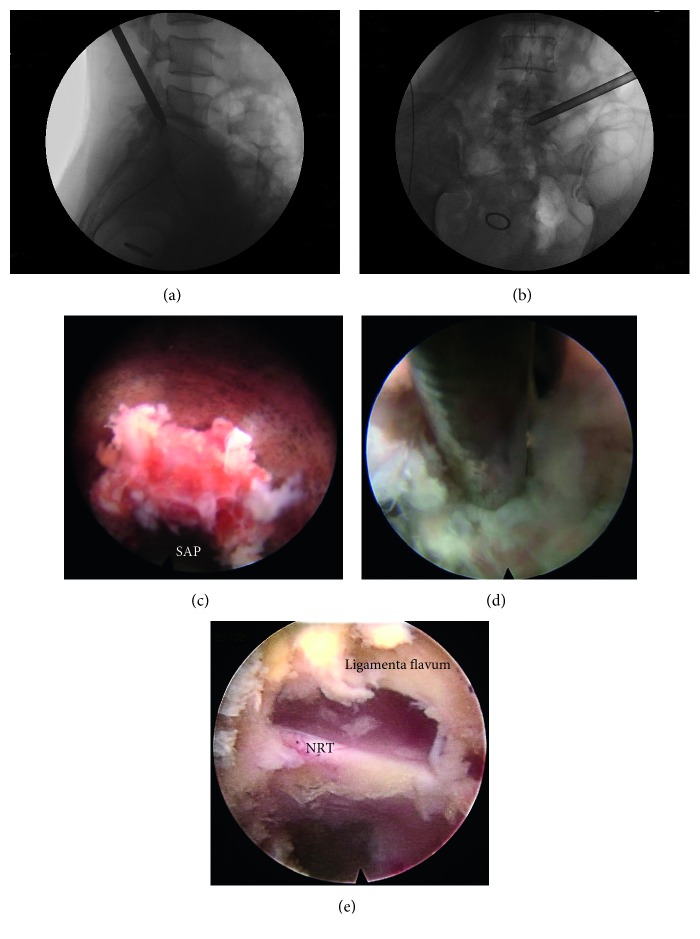
Imaging data during surgeries. (a) The tip of the guide bar lay at the posterior rim of the upper endplate of the SAP facet of the distal vertebrate in the lateral view. (b) The tip of the guide bar lay at the medial pedicle line in the anterior-posterior view. (c) Cutting SAP with a trephine under endoscope. (d) Removing the herniated lumbar disc mass under endoscope during procedure. (e) The operation area after the herniated mass was removed. SAP = superior articular process, NRT = nerve root.